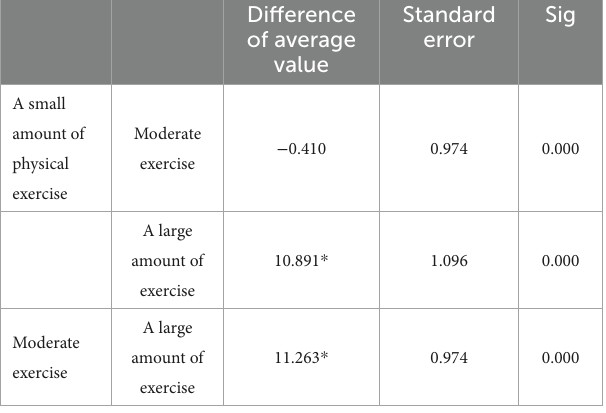
TABLE 3 Test results of anxiety level difference under different conditions of physical exercise.